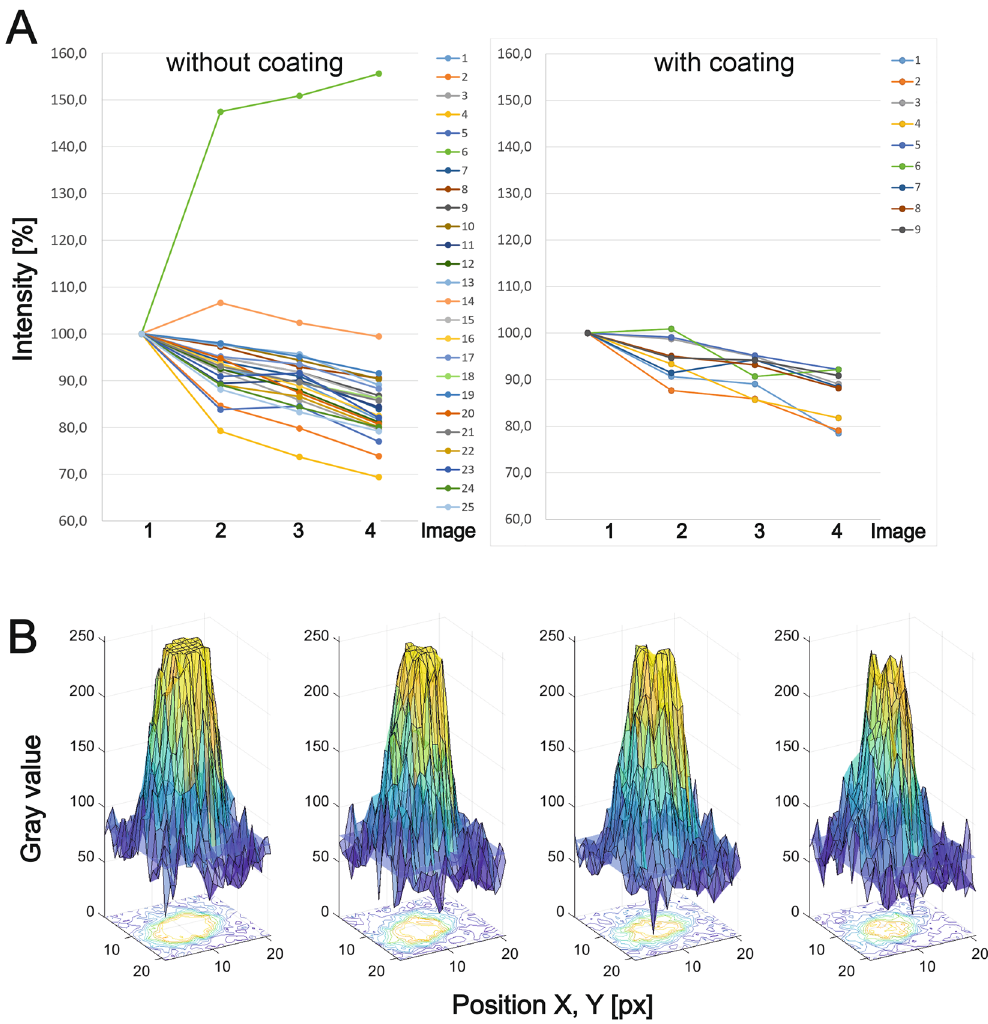
Figure 5. Decay of cathodoluminescence intensities of IRAZOLVE-MITO dye (without and with sputtered gold nanolayer) measured on four consecutive images taken at the same parameters of the CL detector and the SEM (4 keV, 15 µs, 300 pA, 10,367 px/nm). ( A ) The graph shows changes in CL intensities measured at the first and consecutive three scans. ( B ) The CL intensities were measured over the representative uncoated area (area 25 from Fig. S5 A is shown) from first to fourth images (from left to right). The blue plane represents the level of background mean